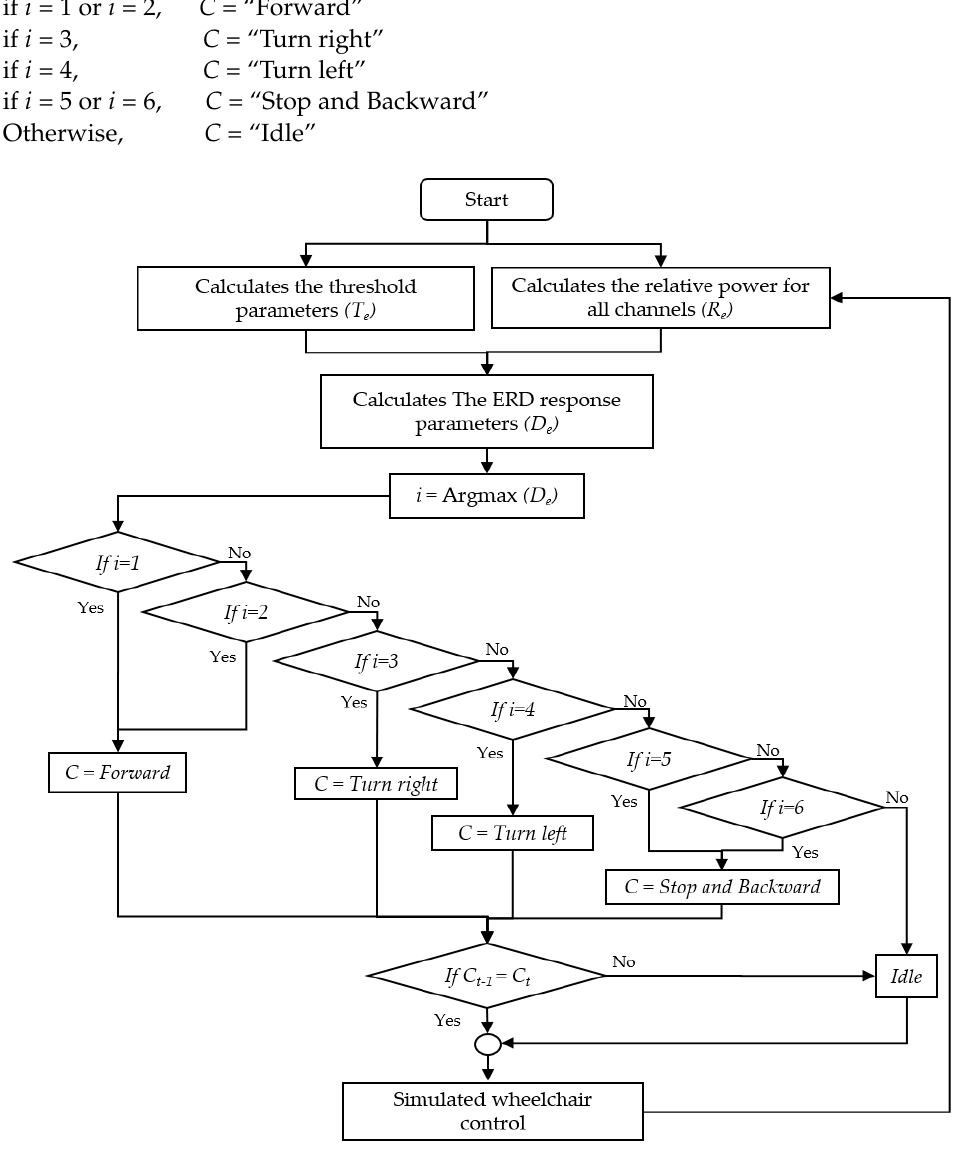
Figure 7. Flowchart of the proposed classification